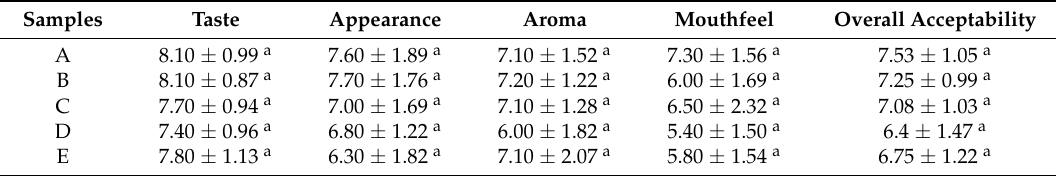
Table 4. Sensory properties of carrot-cucumber